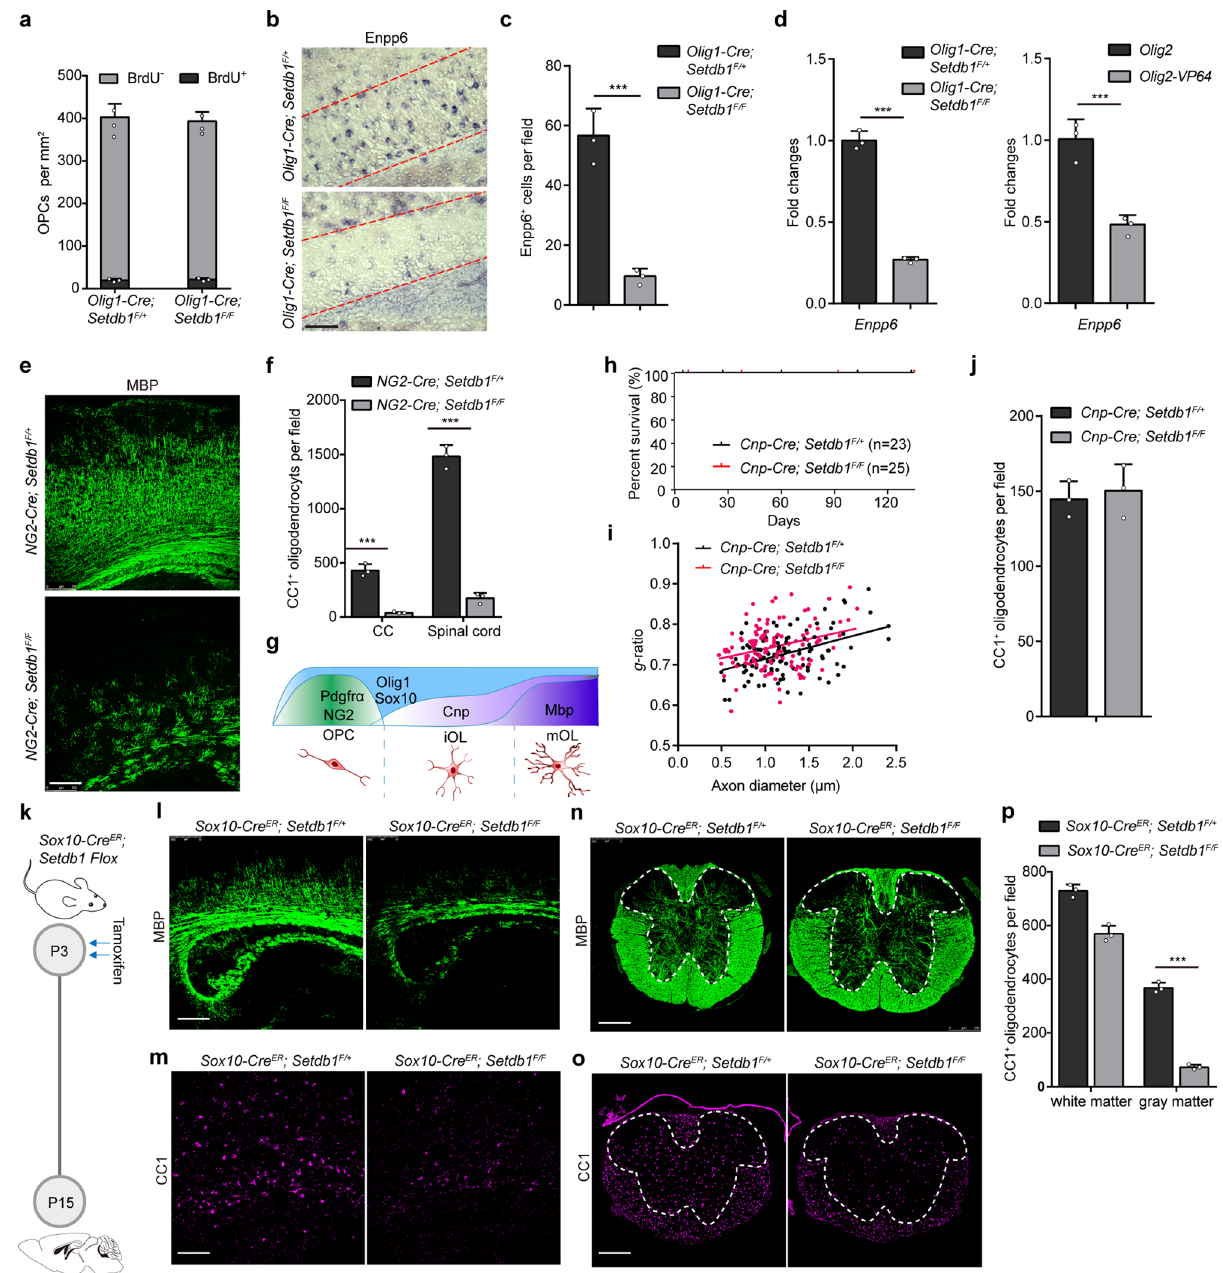
Fig. 5 OLIG2-SETDB1 repressor complex functions at the onset of mouse OPC differentiation. a Quanti fi cation of BrdU + and PDGFR α + cells in the corpus callosum of Olig1-Cre ; Setdb1 F/ + and Olig1-Cre ; Setdb1 F/F mice at P14. b In situ hybridization of Enpp6 + in the corpus callosum at P14. n = 3 control and three mutant mice. c Quanti fi cation of Enpp6 + cells in the corpus callosum at P14. Error bars indicate SEM ( p < 0.001. two-tailed unpaired Student ’ s t test). d Expression of Enpp6 in spinal cords of Setdb1 control and mutant mice (left panel) and rat iOLs transfected with Olig2 or Olig2-VP64 (right panel). Error bars indicate SEM ( p < 0.001. two-tailed unpaired Student ’ s t test). e Immunostaining of MBP in the corpus callosum from NG2-Cre ; Setdb1 F/ + and NG2-Cre ; Setdb1 F/F mice at P14. n = 3 control and three mutant mice. f Quanti fi cation of CC1 + cell in the corpus callosum and spinal cord from NG2-Cre ; Setdb1 F/ + and NG2-Cre ; Setdb1 F/F mice at P14. Error bars indicate SEM ( p < 0.001. two-tailed unpaired Student ’ s t test). g Schematic diagram showing markers of each stage in oligodendrocyte lineage. h Survival curve of Cnp-Cre ; Setdb1 F/ + and Cnp-Cre ; Setdb1 F/F mice. i Quanti fi cation of myelin sheath thickness ( g -ratio) in optic nerves from Cnp-Cre ; Setdb1 F/ + and Cnp-Cre ; Setdb1 F/F mice at P14. n = 3 control and three mutant mice. j Quanti fi cation of CC1 + cells in the spinal cord of Cnp-Cre ; Setdb1 F/ + and Cnp-Cre ; Setdb1 F/F mice at P14. n = 3 control and three mutant mice. k Schematic diagram showing tamoxifen administration to Sox10-Cre ER ; Setdb1 Flox mice in two consecutive days at P3, followed by tissue collection at P15. n = 3 control and three mutant mice. l – o Immunostaining of MBP and CC1 in the corpus callosum ( l , m ) and spinal cord ( n , o ) from Sox10-Cre ER ; Setdb1 F/ + and Sox10-Cre ER ; Setdb1 F/F mice at P14. n = 3 control and three mutant mice. p Quanti fi cation of CC1 + cells in the white matter or gray matter of spinal cord. Error bars indicate SEM ( p < 0.001. two-tailed unpaired Student ’ s t test). Scale bars: 100 μ m in ( b ); 250 μ m in ( e and l – o